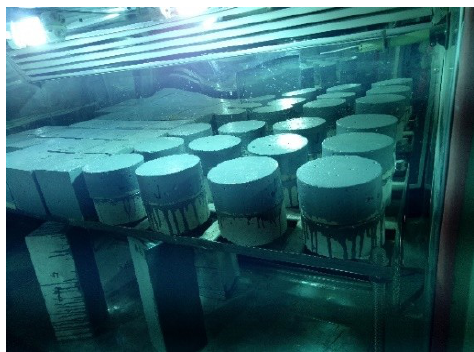
Figure 2. Ultraviolet aging of coated specimens in an artificial climate chamber.